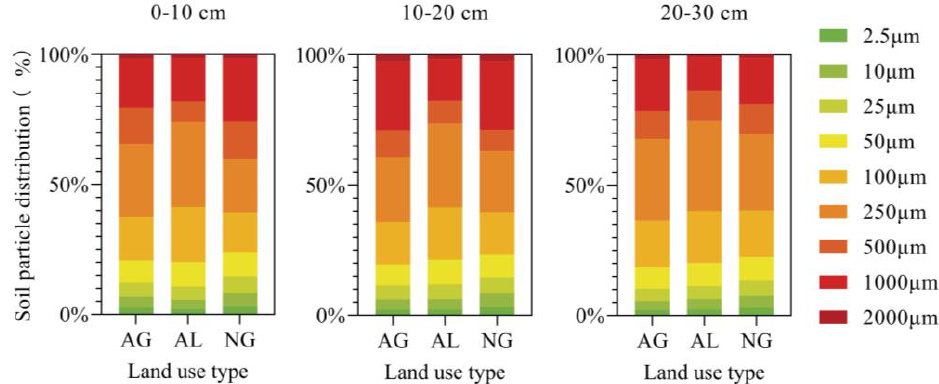
Figure 6. Soil particle distribution. AG: artificial grassland; AL: cropland; NG: natural